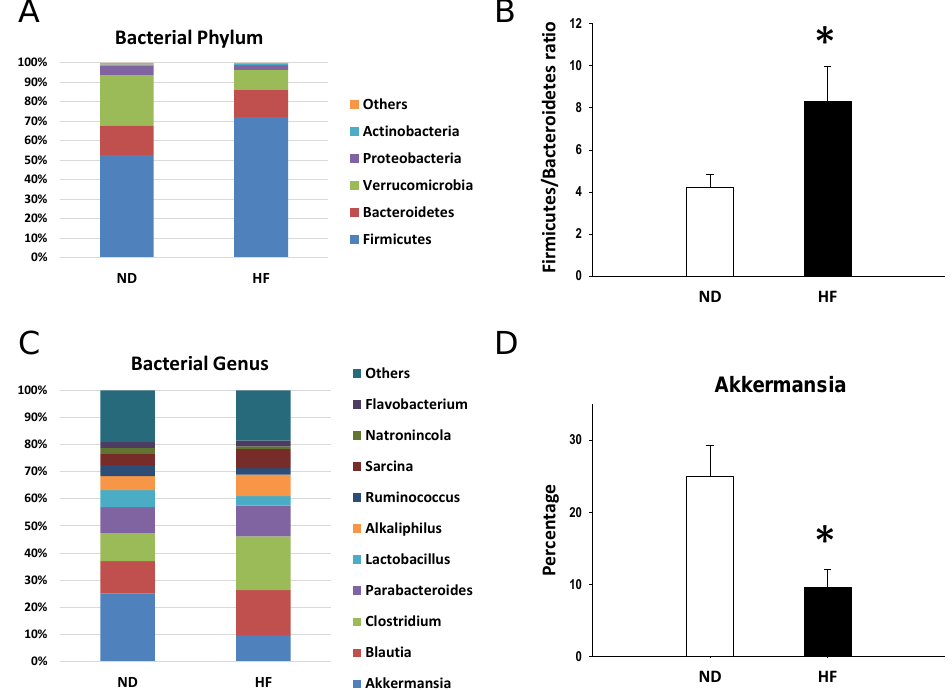
Figure 5. Effect of maternal high-fructose (HF) diet on offspring gut microbiota at 3 weeks of age. ( A ) Relative abundances of the top five phyla. ( B ) The Firmicutes to Bacteroidetes ratio. ( C ) Relative abundances of the top 10 genera. ( D ) Relative abundances of the genus Akkermansia . n = 16/group. * p < 0.05 vs. ND.